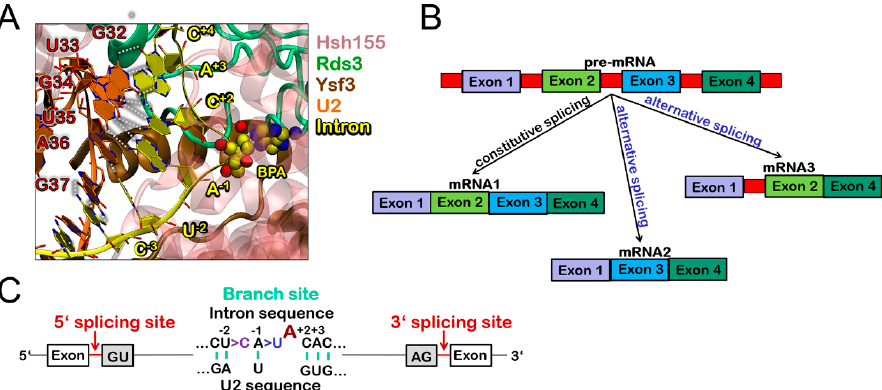
Figure 1. ( A ) Intron/U2 double helix at branch point site (BPS), as trapped in the B act cryo-Electron microscopy (EM) structure (Protein Data Bank (PDB) code 5GM6). The bulged adenine ( A ) at the BPS is shown in van der Waals (VDW) spheres and labelled as branch point adenosine (BPA). The surrounding Hsh155, Rds3, and Ysf3 proteins are depicted as pink, green, and brown cartoon representations, respectively. Hydrogen (H)-bonds of base-pairs between intron and U2 are highlighted as white dashed lines. ( B ) Simplified representation of constitutive and alternative splicing. Large boxes depict the exons, while small red rectangles refer to introns. Constitutive splicing (resulting in mRNA1) is schematically presented as exons ligated in the same order in which they appear in pre-mRNA. In alternative splicing, one pre-mRNA can be spliced in different transcripts (mRNA2, mRNA3), encoding for different proteins. ( C ) Key intron recognitions sites. BPA at the branch site is indicated with a dark red letter. Replacement either of A to U at position -1 or of U to C at position-2 disrupts the intron-U2 base-pairing,